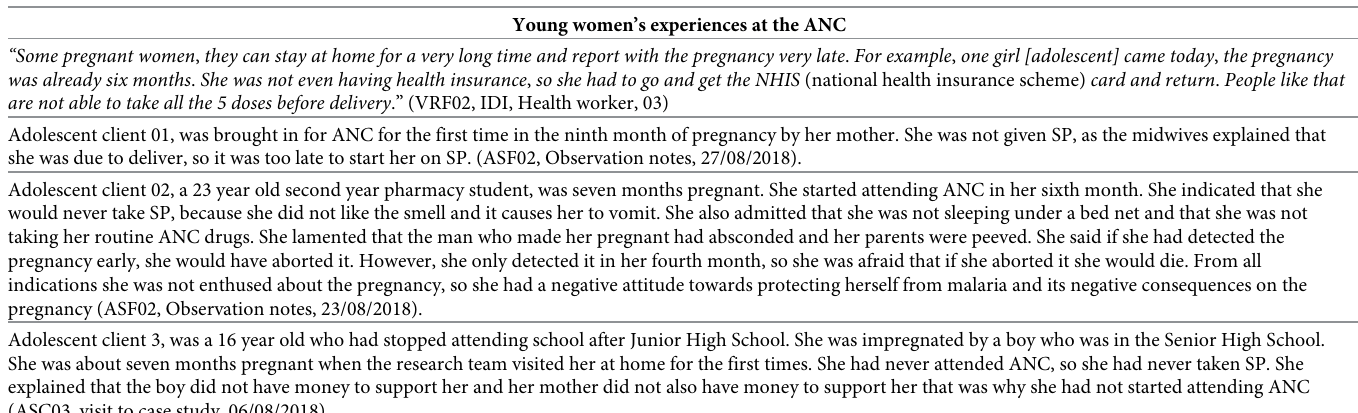
Table 5. Young women’s experiences in seeking ANC care and IPTp-SP